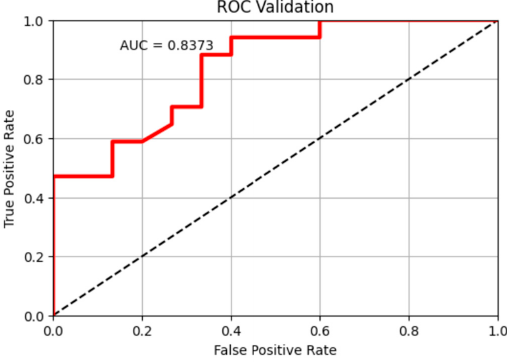
Figure 11. The receiver operating characteristic (ROC) curve of the risk results.